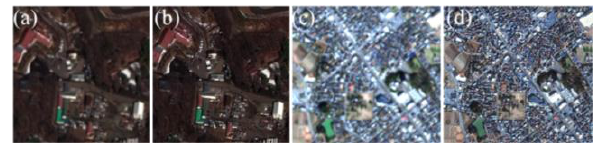
Figure 12 . Comparison of interpolated (bicubic interpolation) and model output (a) interpolated image (0.5m) (b) EXP1 model output (0.5m) (c) interpolated image (2.5m) (b) EXP2 model output (2.5m).